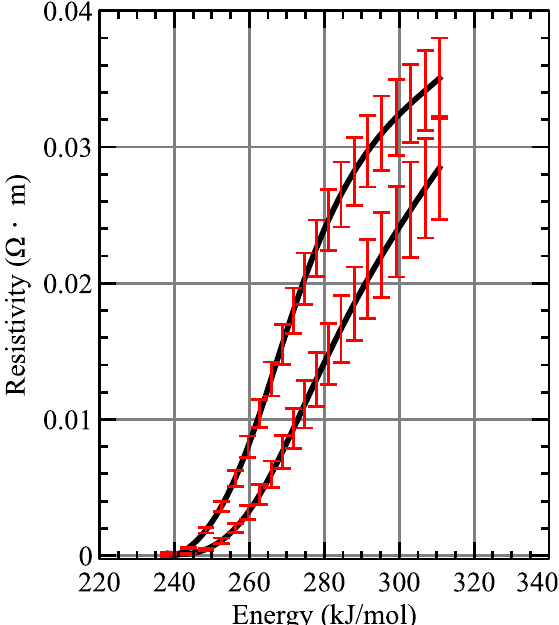
Figure 5. Iron metal gas resistivity limits.